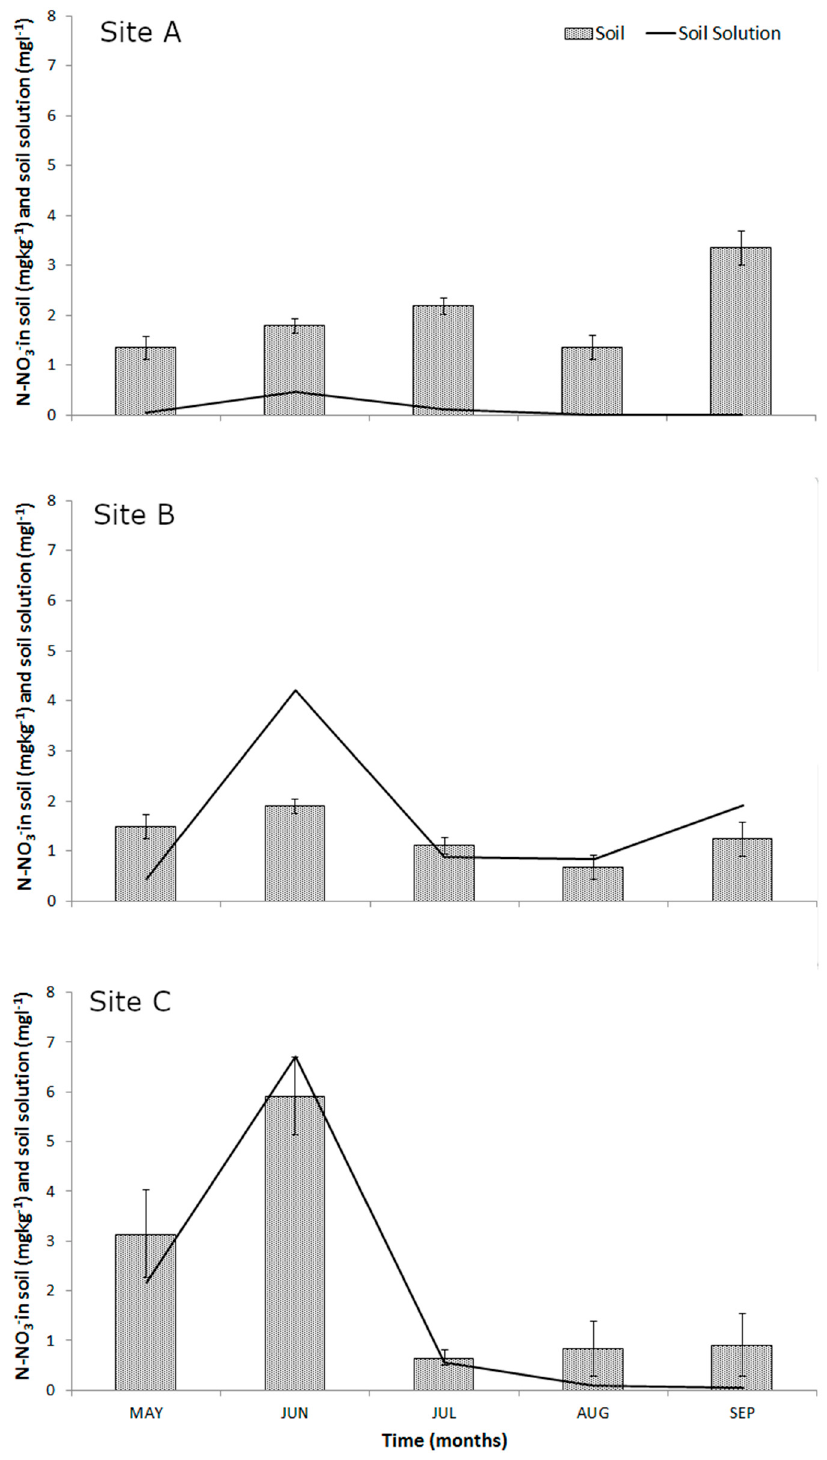
Figure 7. Trends of soil (mg kg − 1 ) and soil solution (mg L − 1 ) N-NO 3 − among the three study sites in the snow-free season (mean values of 2015 and 2016).